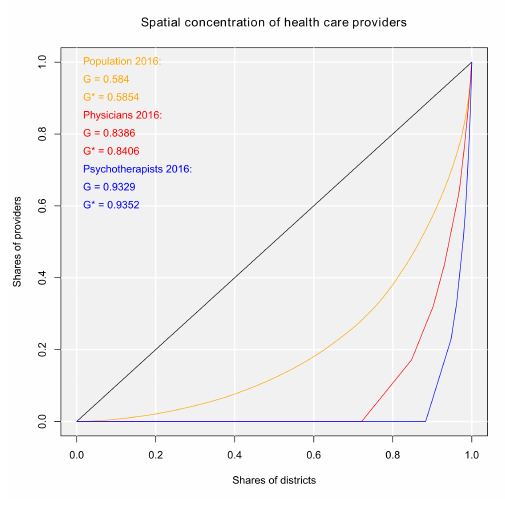
Figure 1: Lorenz curves for the spatial concentration of health care